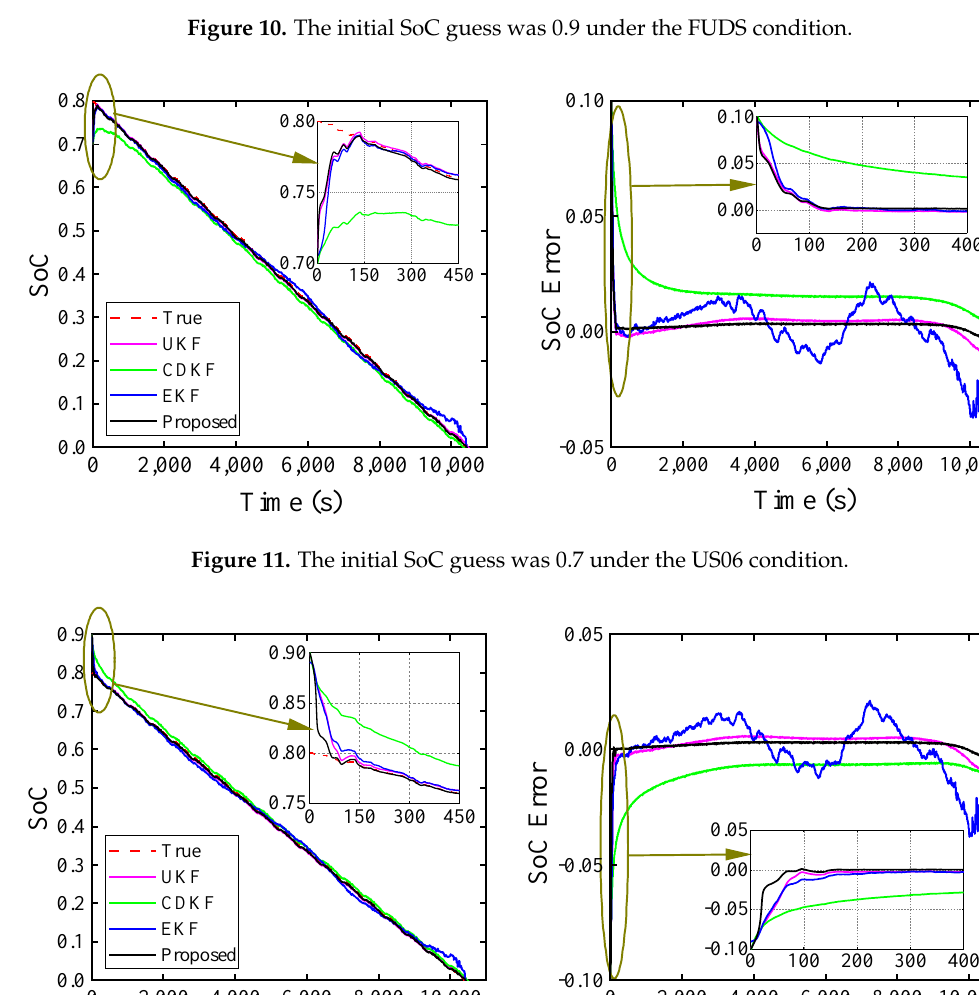
Figure 13. The four evaluation indexes of the initial SoC guess were 0.7 under the FUDS condition.